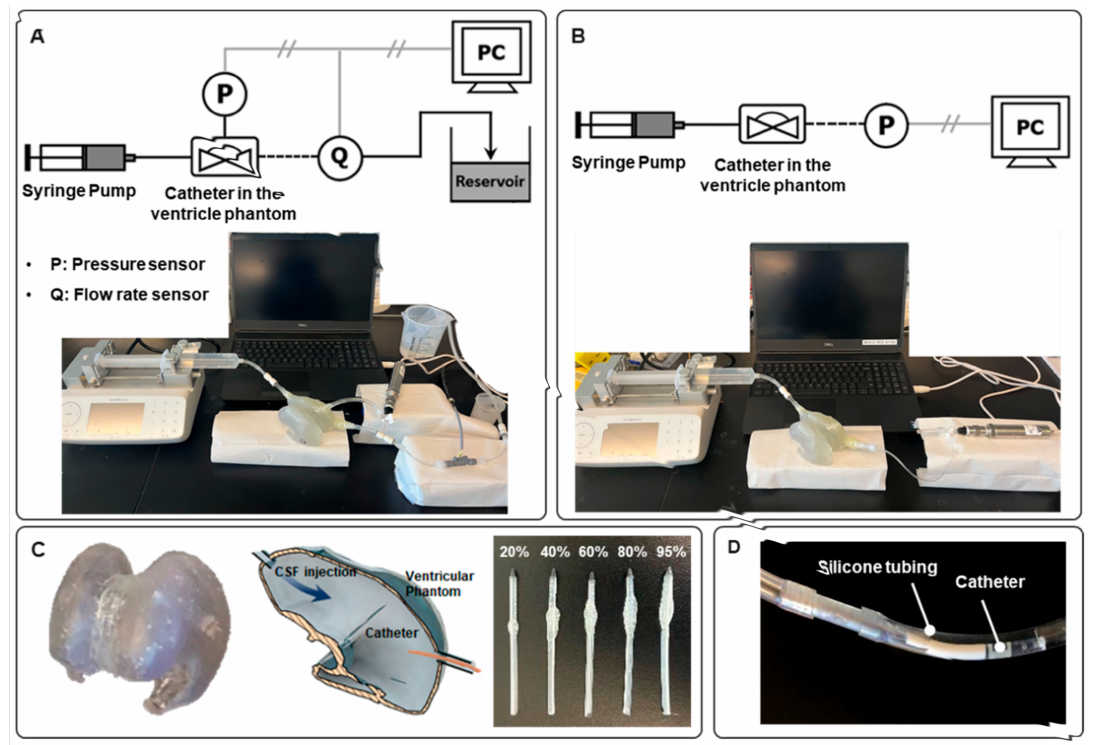
Figure 1. Experimental setup of the catheter performance system. A syringe pump (Fusion 200-X, Chemyx, Inc., Stafford, TX, USA) injecting artificial CSF at 1 mL/min was used as the fluid source. ( A ) Commercial pressure transducer (PX409-100 GUSBH, Omega, Inc., Biel/Bienne, Switzerland) and flow rate sensor (SLF3S-0600F, Sensirion, Inc., Stäfa, Switzerland) were used for measurement of internal pressure of the phantom and CSF flow rate through the catheter, respectively. ( B ) Exper- imental setup for pressure measurement in the catheter. ( C ) The 3D-printed ventricular phantom; actual printed part ( left ). The phantom was designed by Fusion 360 software and fabricated by SLA (Stereolithography) 3D printer (Form 3B, Formlabs) using elastic resin (Elastic 50A, Formlabs). Cross-sectional schematic of the phantom with the inserted catheter (middle). Catheters obstructed by epoxy resin by 20%, 40%, 60%, 80%, and 95% (from left to right ). ( D ) A catheter was inserted into the silicon tubing instead of the